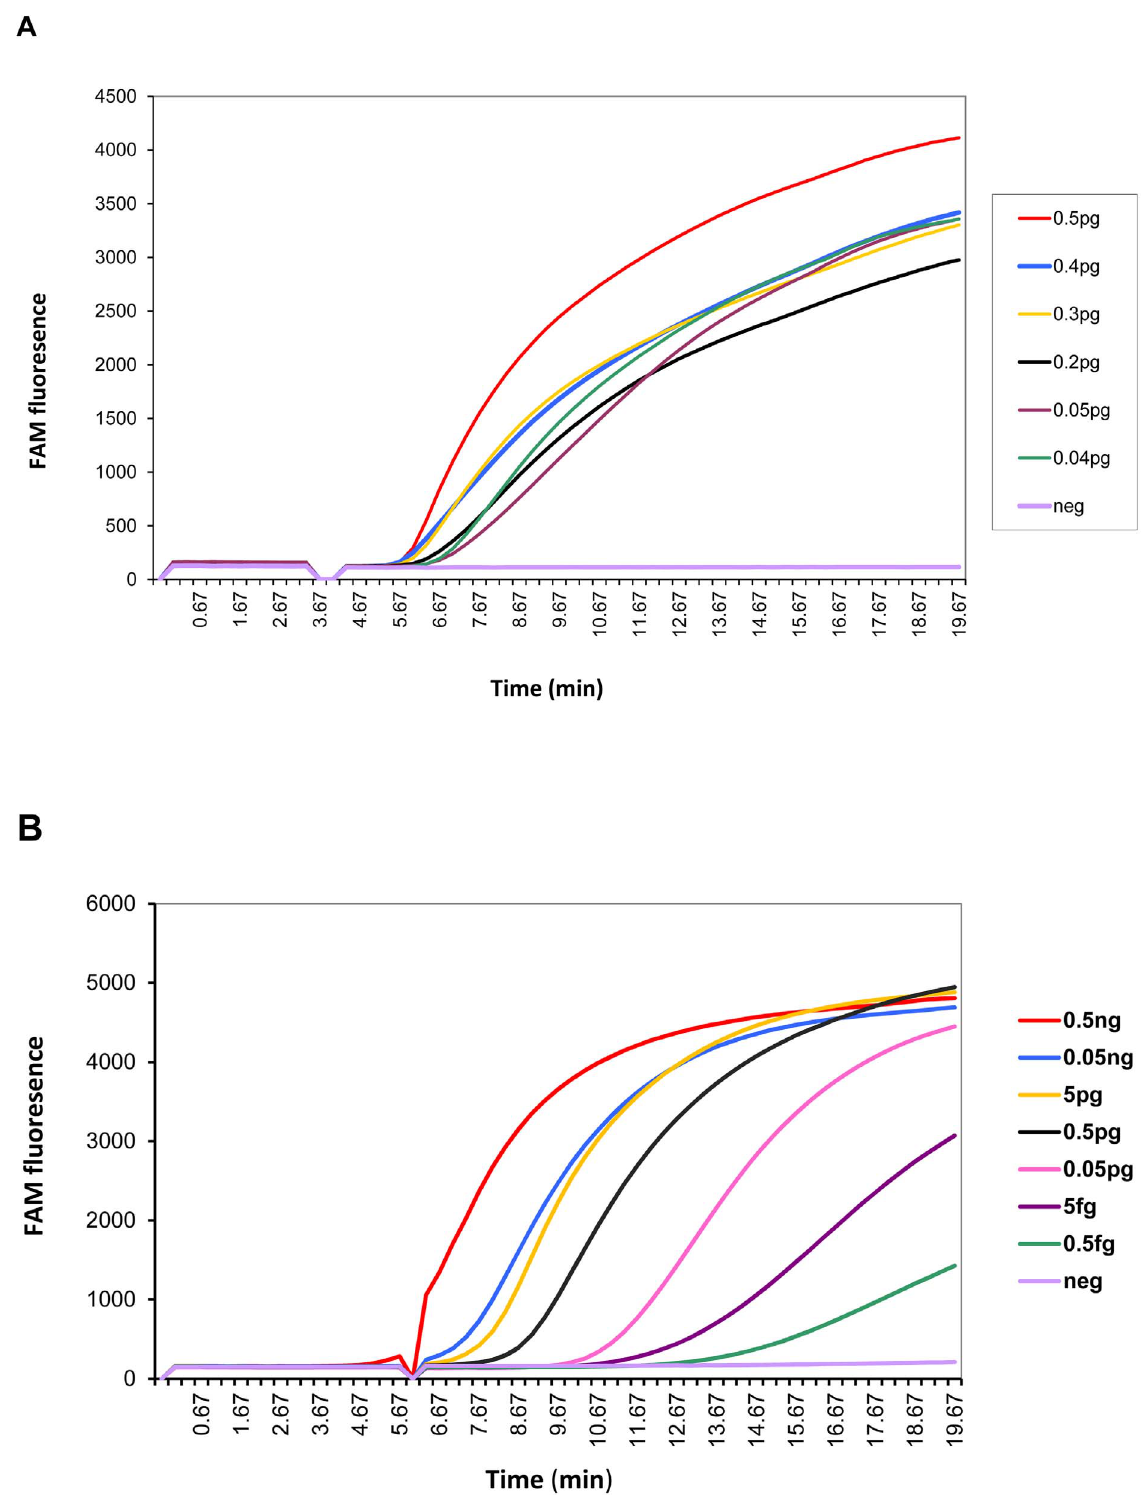
Figure 2. Real-time RPA amplification of IS 1081 and IS 6110 . Figure 2a shows the real time detection of IS 1081 amplification from a dilution series of quantitated M. bovis BCG DNA with a sensitivity as low as 0.04 pg of DNA per reaction. Figure 2b shows the real time detection of IS 6110 amplification from a dilution series of quantitated M. bovis BCG DNA BCG DNA with a sensitivity as low as 5.0 fg of DNA per reaction.